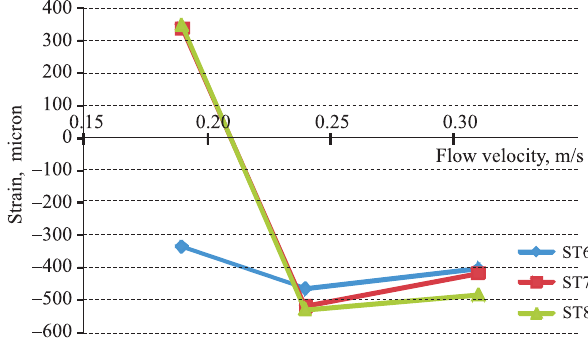
Fig. 17. Effect of flow velocity on pile strain at mid-span